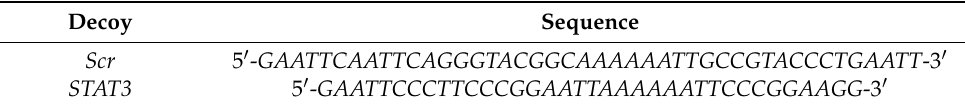
Table 1. Target sequences of the decoy ODNs used in this study. Decoy